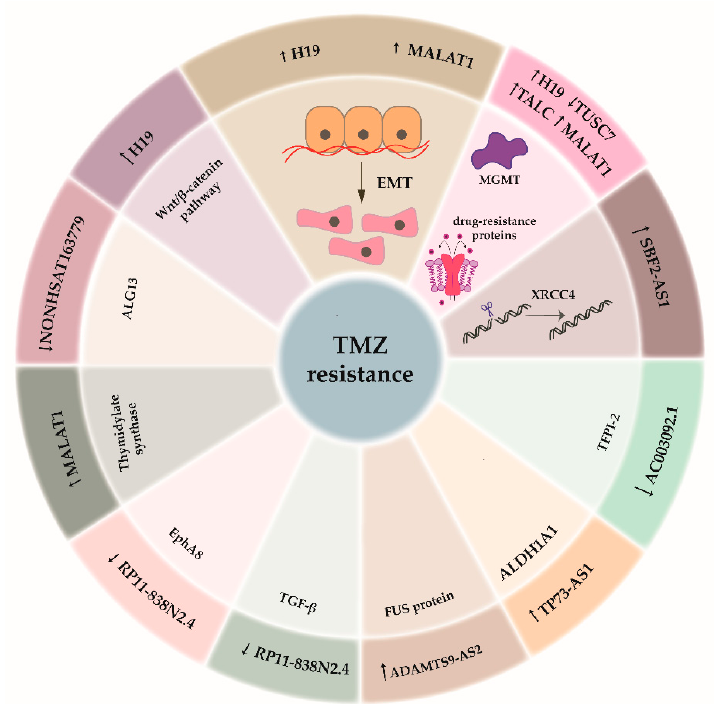
Figure 3. lncRNAs involved in glioblastoma therapy resistance. In the outer shell lncRNAs involved in temozolomide (TMZ) resistance are presented. In the inner shell, the pathways regulated by each specific lncRNA are presented.